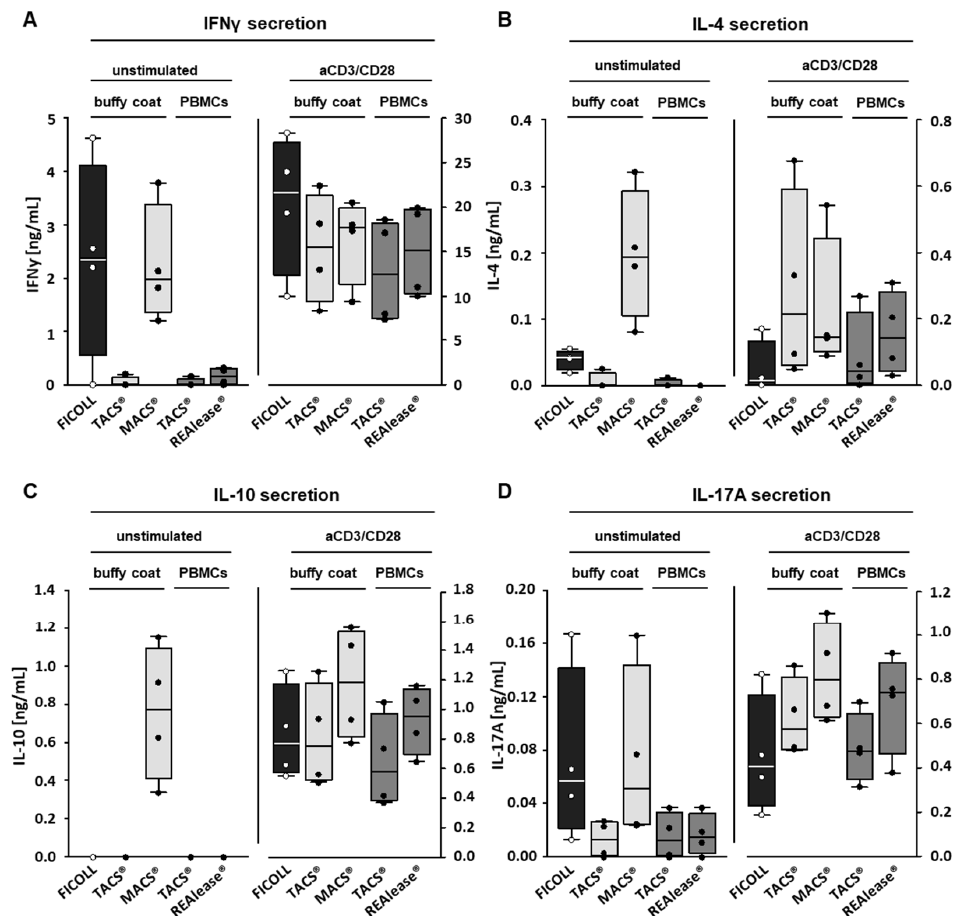
Figure 6. Effect of the different CD3-dependent isolation methods on cytokine production. To determine the effect of the different isolation methods on the production of cytokines induced by CD3-positive cells, the VPD450-labeled cells were cultured (1 × 10 6 /mL) in the presence of medium or with Dynabeads™ Human T-Activator CD3/CD28 at a bead-to-cell ratio of 3:1 (anti CD3/CD28 stimulation (aCD3/CD28)). After six days, IFN γ ( A ), IL-4 ( B ), IL-10 ( C ), and IL-17A ( D ) concentrations were determined by ELISA, n = 4. Box plots indicate median (horizontal lines), interquartile range (box), and range (whiskers).